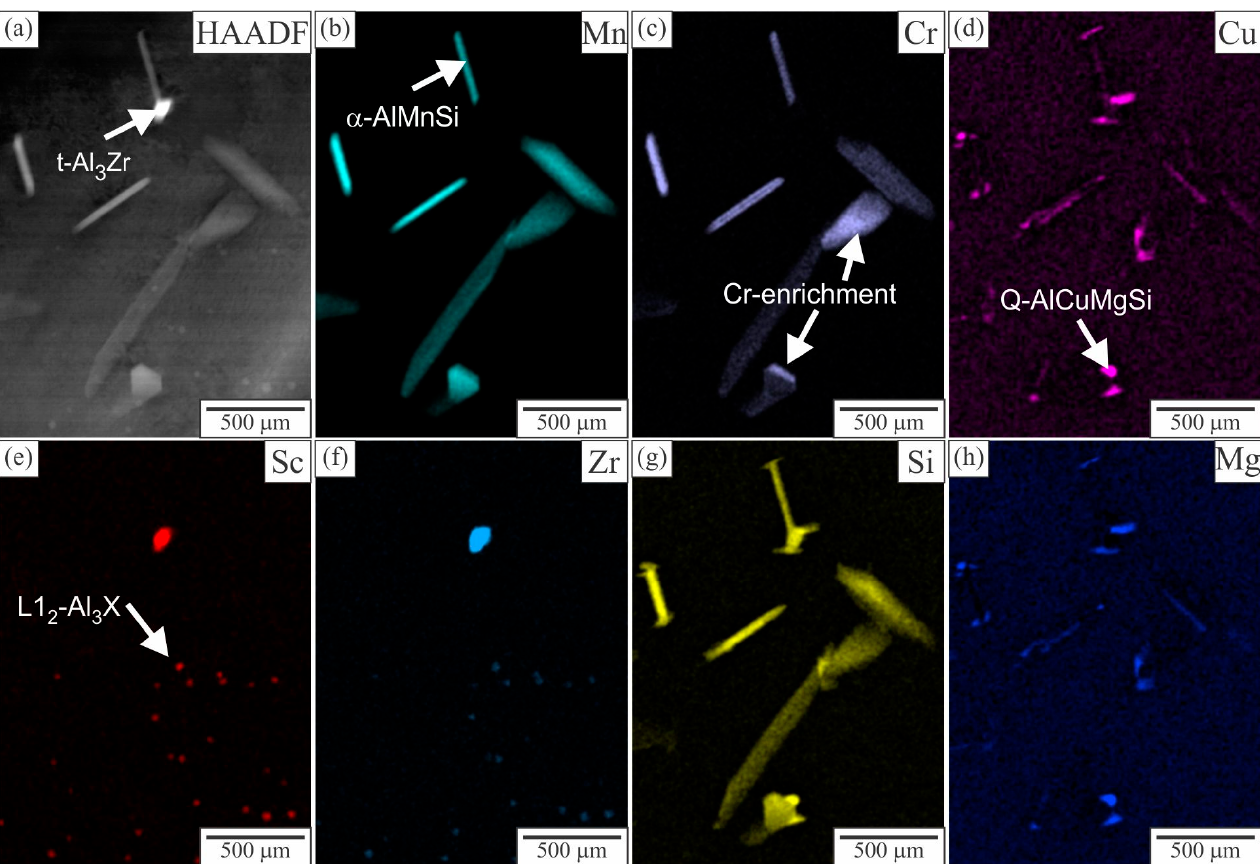
Figure 13. Distribution of the elements within the matrix in the area with coarser dispersoids (T6 temper). ( a ) HAADF micrographs, mapping of ( b ) Mn, ( c ) Cr, ( d ) Cu, ( e ) Sc, ( f ) Zr, ( g ) Si and ( h ) Mg.